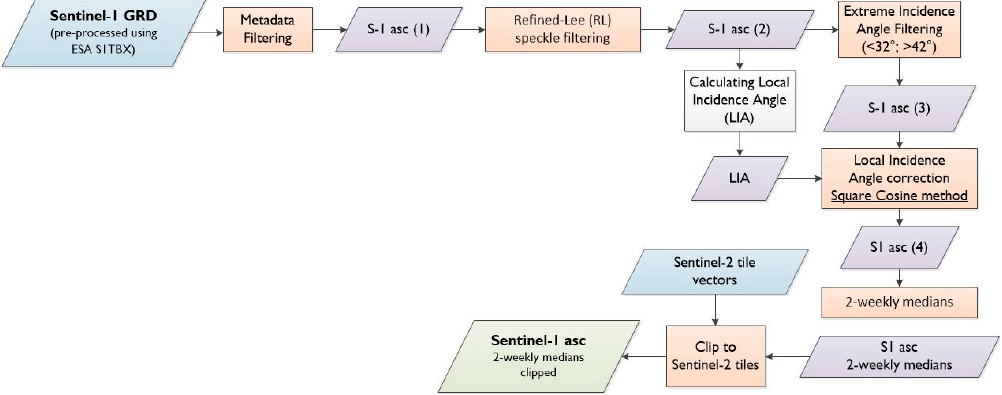
Figure 4. Sentinel-1 data pre-processing and feature generation.